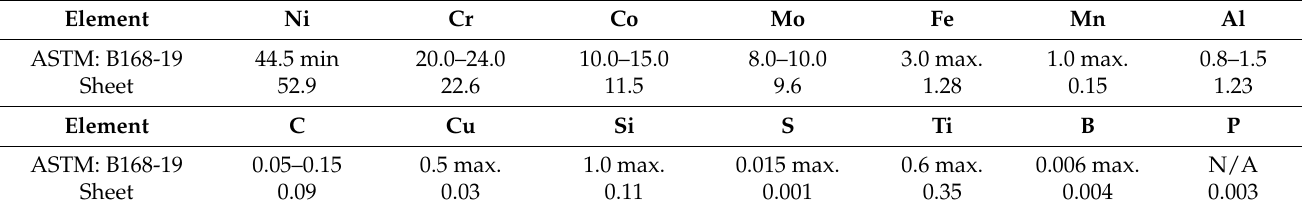
Table 1. Chemical composition of the Alloy 617 sheet in wt.%.